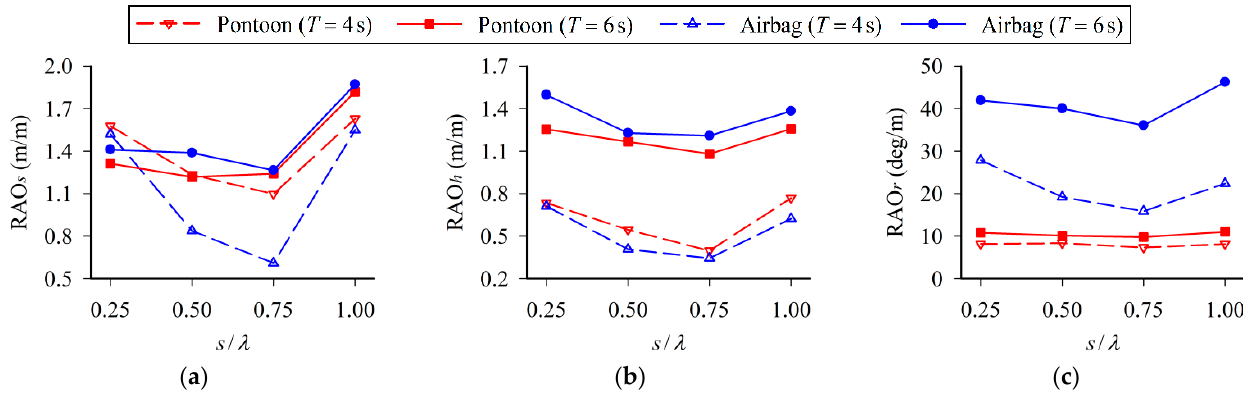
Figure 14. Comparison of the response amplitude operators of the double-row floating breakwater with different separation distance s / λ : ( a ) Sway motion RAO s ; ( b ) Heave motion RAO h ; ( c ) Roll motion RAO r .